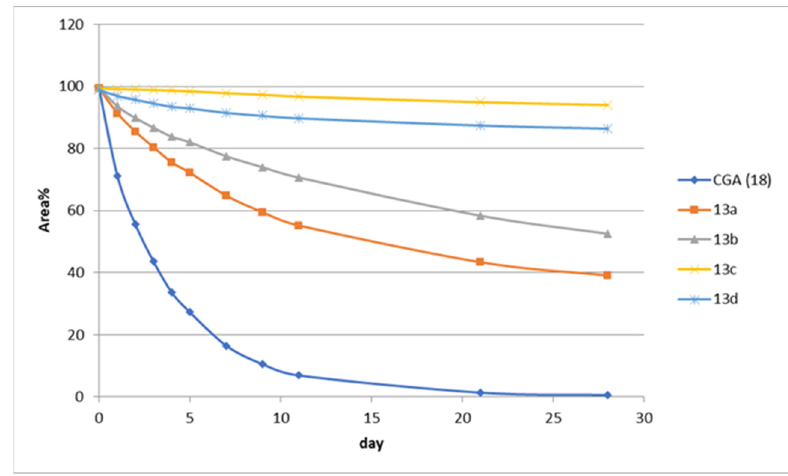
Figure 2. Stability of CGA acyl analogues (Area%) over the time in methanol. Table 2. Stability of CGA acyl analogues in methanol over the time (28 days) a . Acyl